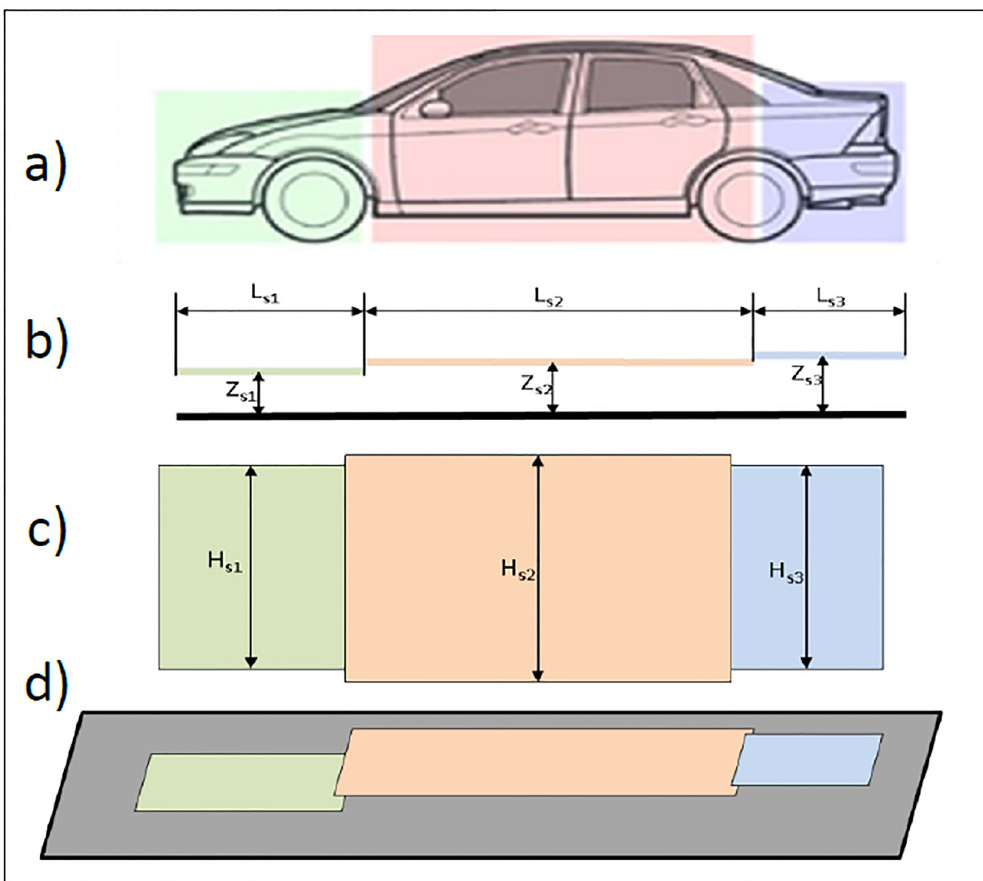
Fig 4. Vehicle modeled in three sections: (a) vehicle side view, (b) model side view, (c) model plan view and (d) model perspective view.